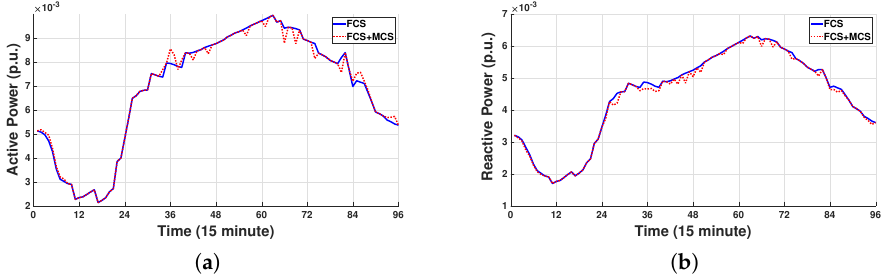
Figure 8. Comparison of total active and reactive power consumption at three FCSs with and without MCSs. ( a ) Active power. ( b ) Reactive